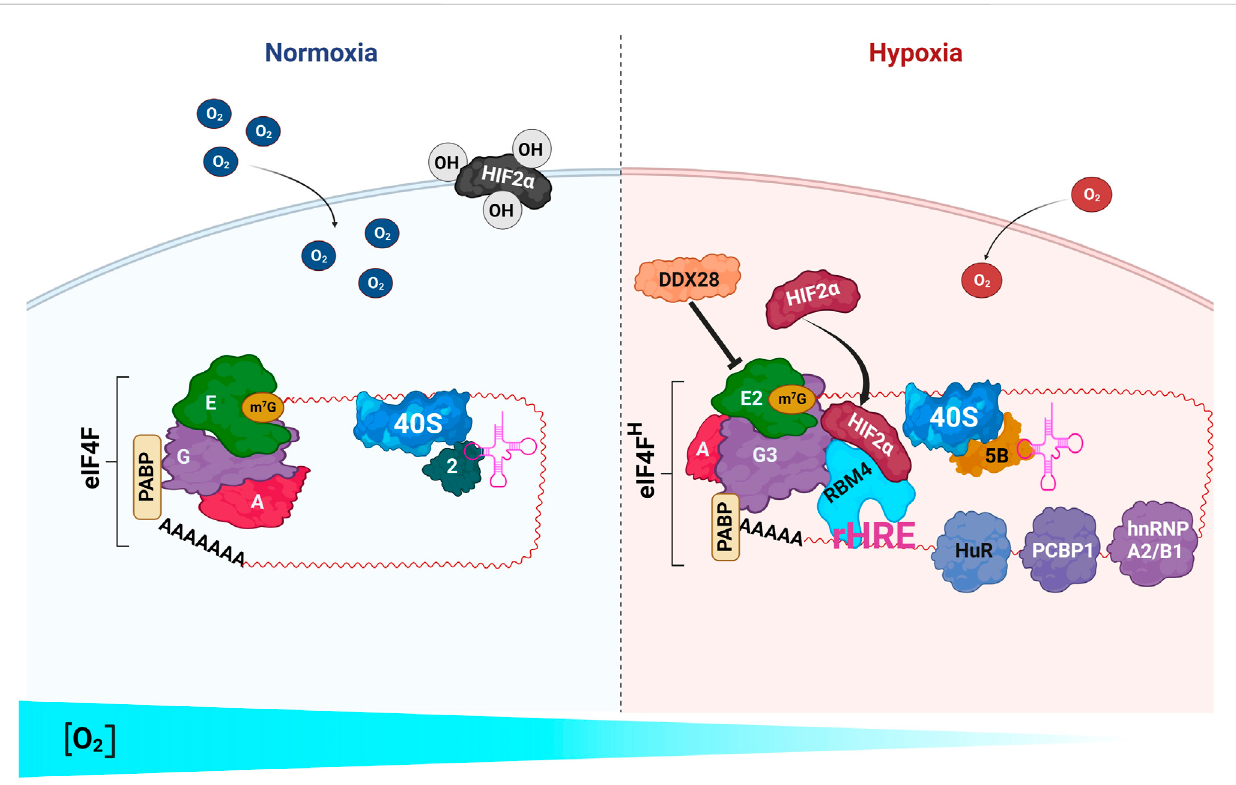
FIGURE 6 Two different machineries drive mRNA translation initiation under normoxia and hypoxia in GB. Only the relevant proteins are depicted. Left) A canonical eIF4F complex,formedbyeIF4E( E ),eIF4G( G ),andeIF4A( A ),drivesmRNAtranslationinitiationundernormoxicconditions. Right) Theswitchto a high hypoxia condition leads to the assembly of a “ hypoxic eIF4F ” ( eIF4F H , formed by eIF4E2 , eIF4G3 , and eIF4A ) that replaces the canonical eIF4F to drive the translation of the mRNAs possessing a hypoxia response element ( rHRE ). eIF4F H also makes a complex with HIF2 α and RBM4. During hypoxia, eIF5B, instead of eIF2, delivers tRNAs to the translating ribosome. Other RNA-binding proteins, such as HuR, PCBP1, and hnRNP A2/B1 bind the mRNAs being translated. The RNA helicase DDX28 represses HIF2 α and eIF4E2 activities during eIF4E2-driven translation (Evagelou et al.,